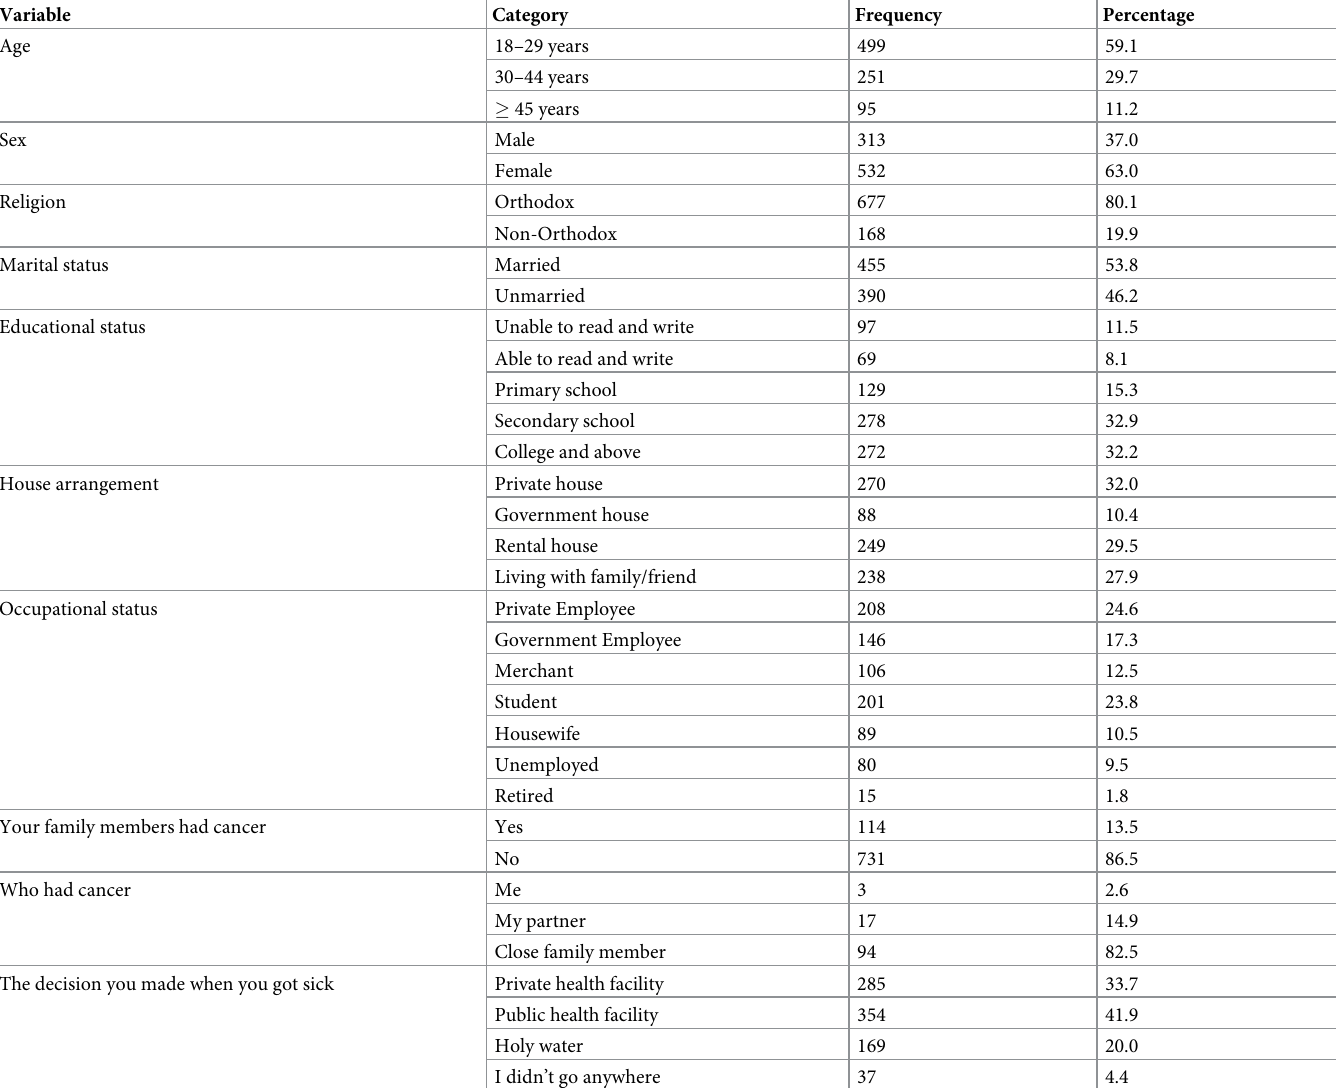
Table 1. Socio-demographic characteristics of the study participants in Bahir Dar city, northwest Ethiopia (n = 845).